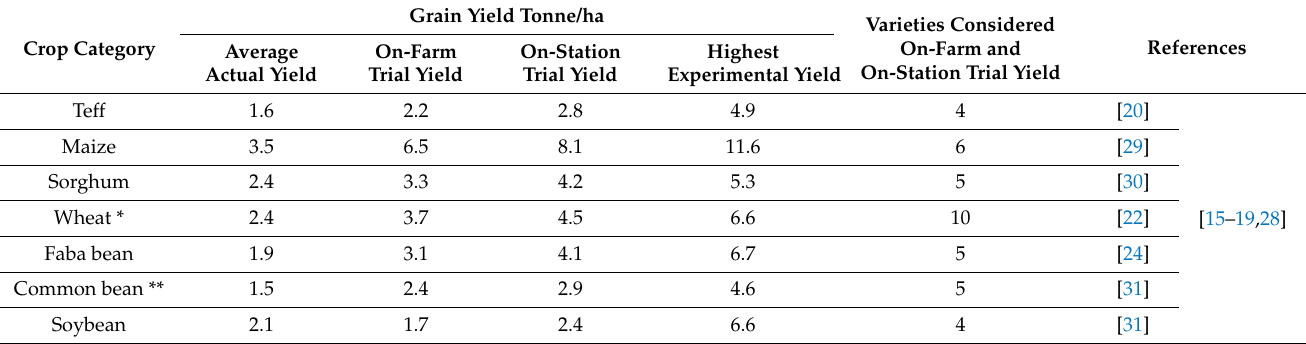
Table 1. Yield gap indicators in major grain legumes and cereals.